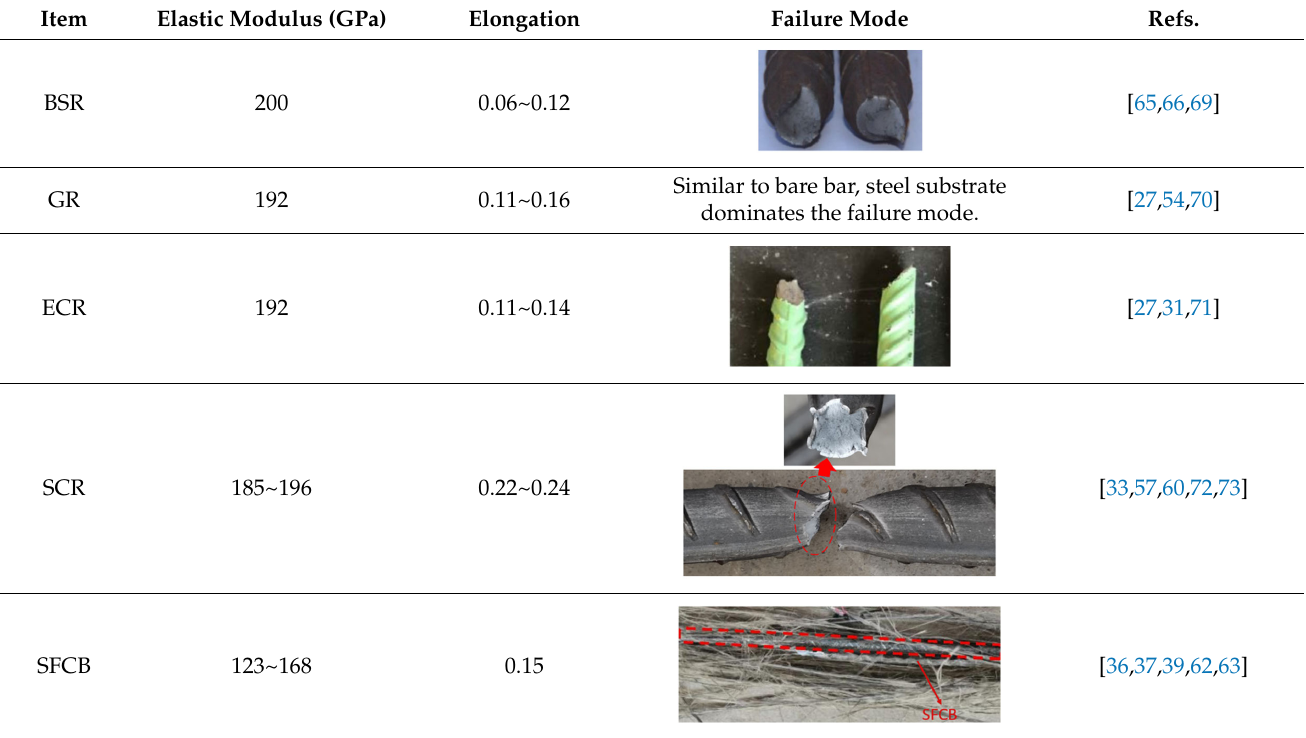
Table 2. Tensile properties of reinforcements.